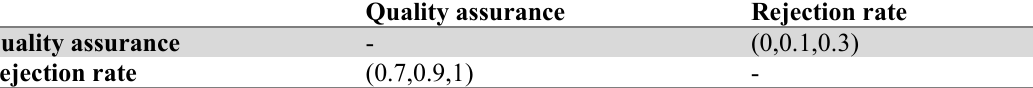
Paired-wise comparison of quality sub-criteria